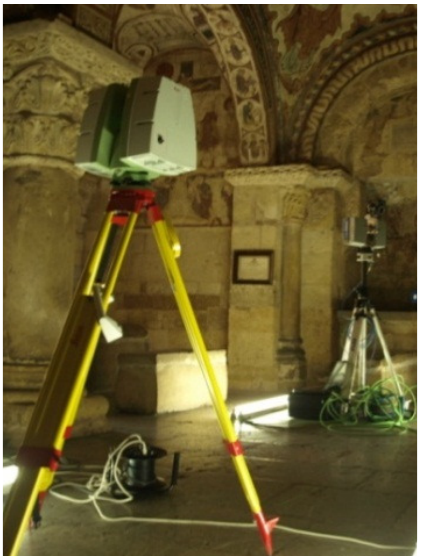
Fig 1. Leica ScanStation C10 and Faro Photon 80 face to